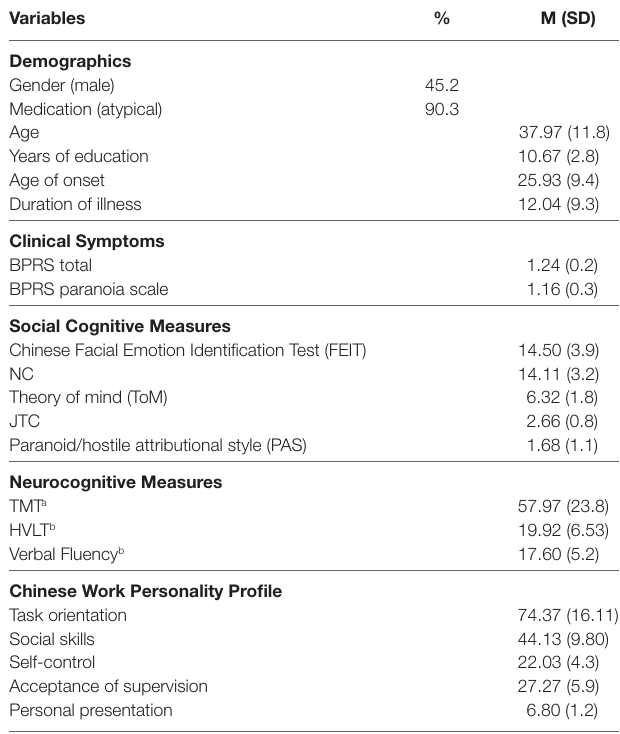
TaBle 1 | Demographic and clinical characteristics ( N =